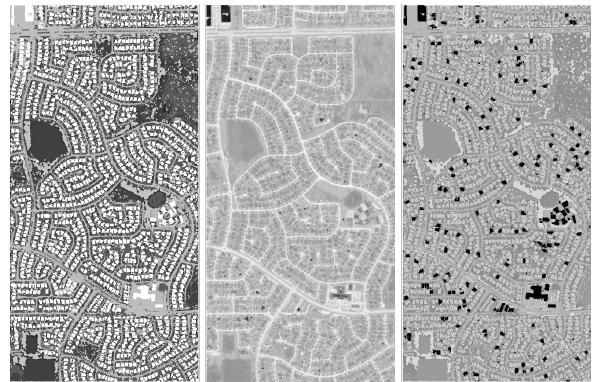
Figure 1. Orthophotos of urban test areas in the City of Melville. Note the different scales of areas.